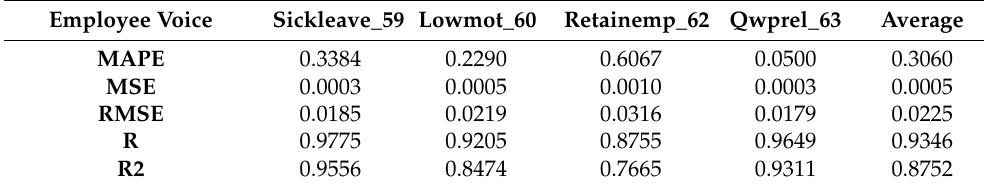
Table 11. Testing results for the effect of employee voice on employee wellbeing.